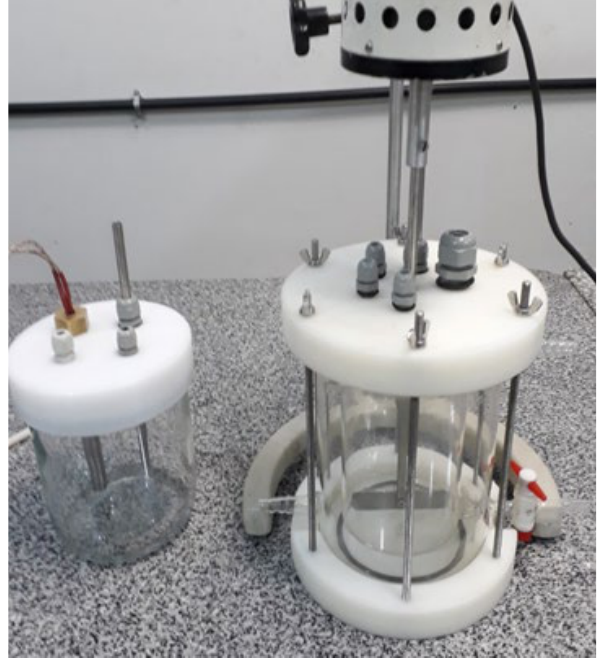
Figure 4. Biodigester with heating and stirring system.